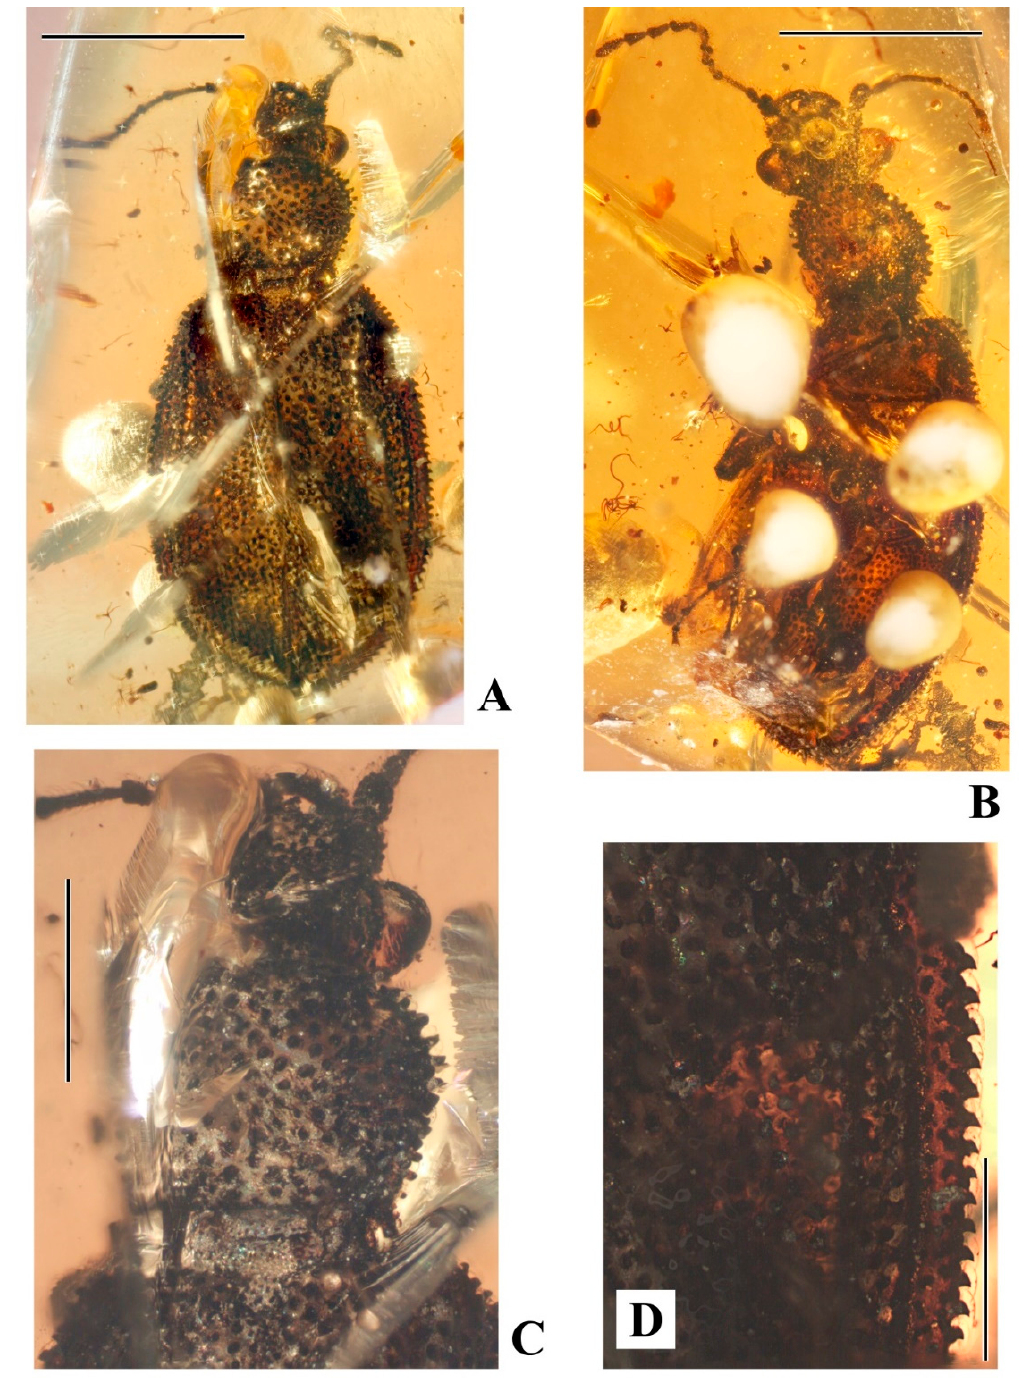
Figure 7. Ommatinae (Cupedidae): Cionoccups manukyani sp. nov. , holotype GPIH 4984, coll. C. Gröhn 11186 (Lower / Upper Cretaceous: Upper Albian / Lower Cenomanian; Myanmar, Kachin, Burmese amber): A —beetle, dorsal, B —same, ventral, C —head and prothorax, dorsal; D —elytral side, dorsal; length of inclusion 7.3 mm, scale bar for A and B = 2.5 mm, scale bar for C = 1.4 mm, scale for D = 0.8 mm;